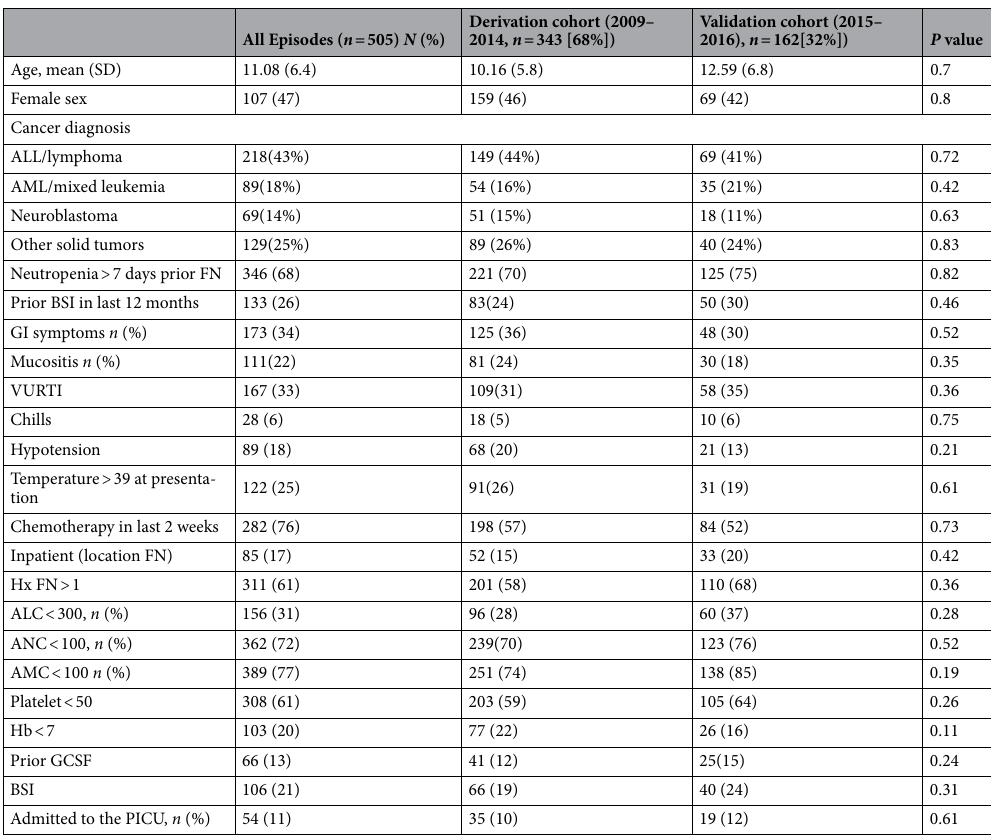
Table 2. Characteristics, variables and outcomes in FNEs among derivation and validation cohorts ( N =